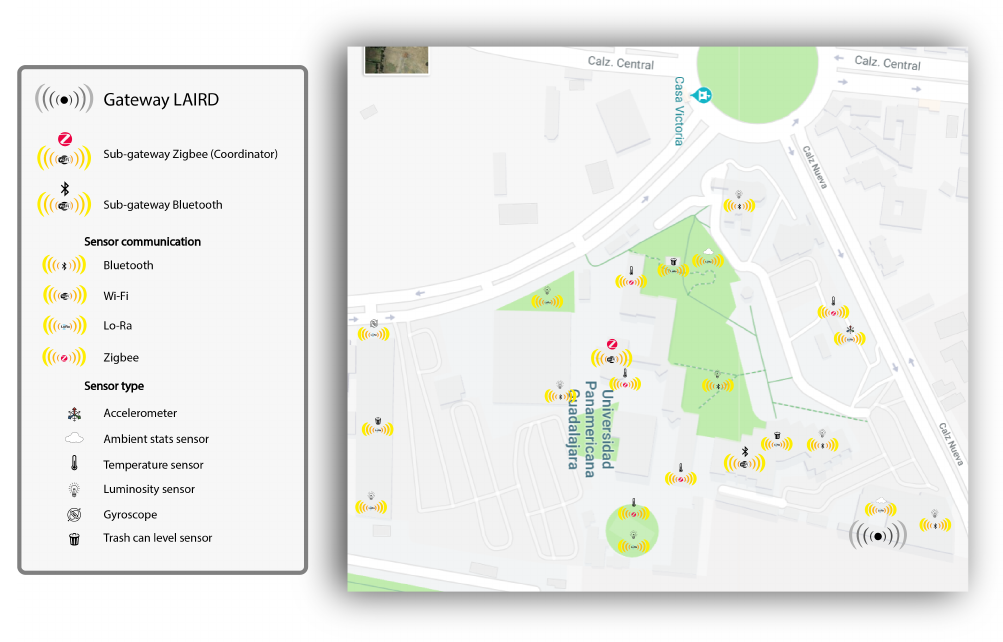
Figure 4. Network sensors position along the university